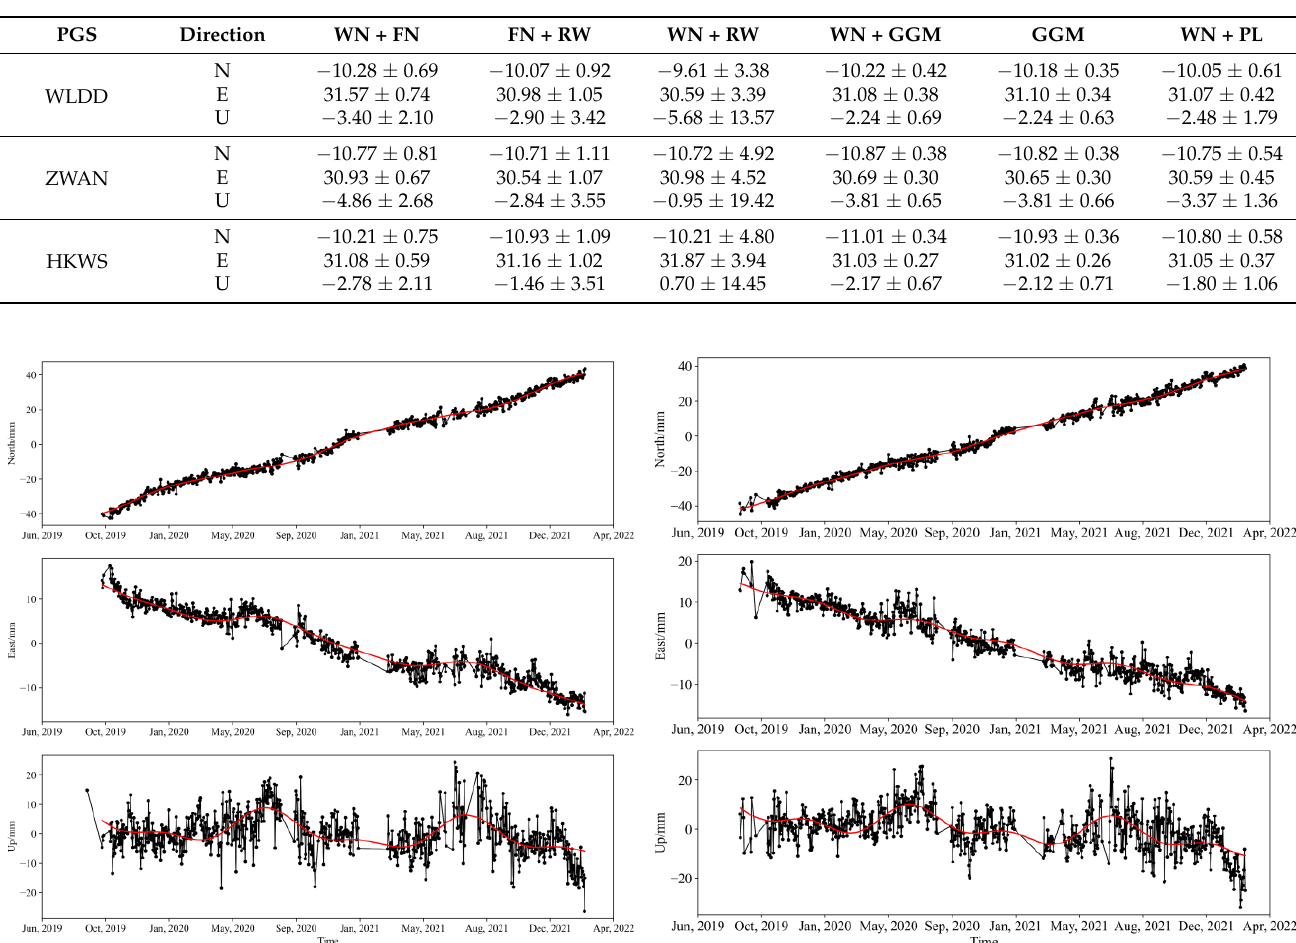
Figure 7. Velocity ( left ) and uncertainty ( right ) differences (mm/year) between six selected noise models and SOPAC. The red dots represent the median value between the solution of this research and the SOPAC. The blue lines represent the RMS of the values. The violin is the interquartile range. Table 2. PGS velocity of the WSCS. (Unit: mm/year).